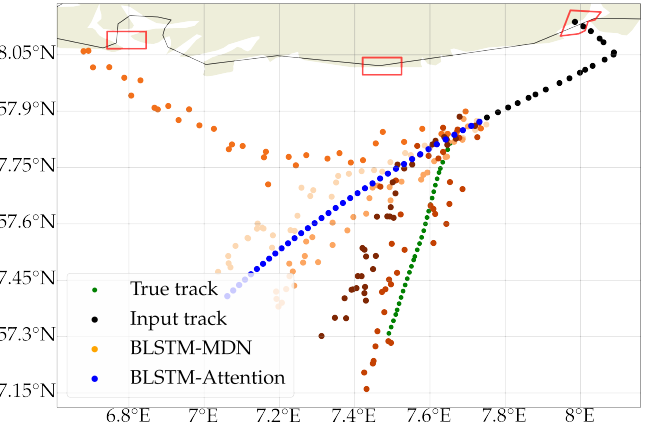
Figure 8. Qualitatively comparison of the predictions from the BLSTM-MDN model (orange shaded points) and the BLSTM-Attention model (blue points). Even if the BLSTM-Attention model had a lower mean distance error that the BLSTM-MDN model, we can see that the BLSTM-MDN model can capture the different possible outcomes better than the BLSTM-Attention